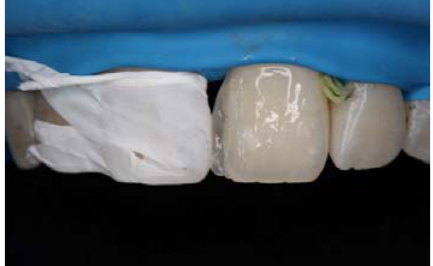
Figure 4: The adjacent central incisor was covered with Teflon band while the other was restored. A thin layer of JE shade transparent composite resin was used palatinally as